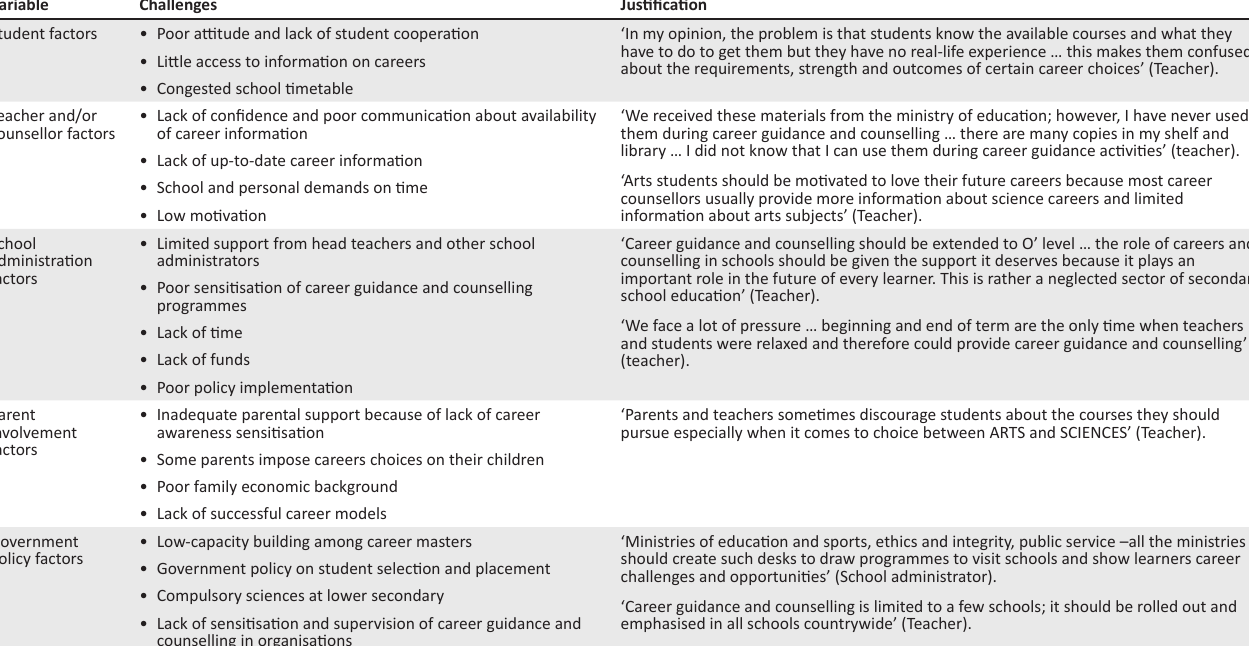
TABLE 4: Views from teachers about challenges faced by schools during implementation of career guidance and counselling.